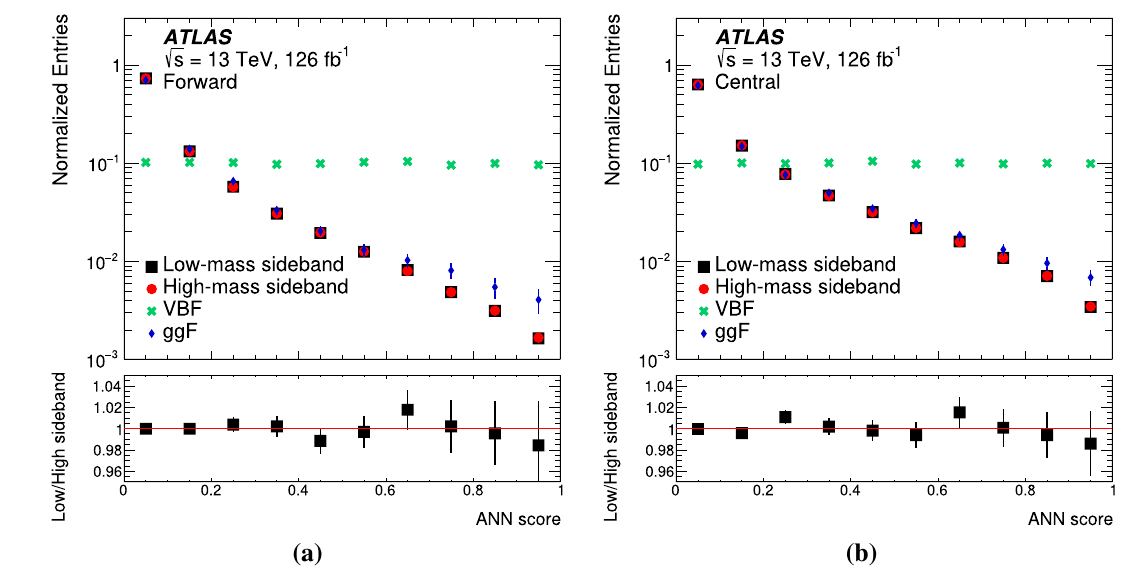
a Forward channel and b Central channel. The bottom panel shows the ratio of the low mass to high mass sidebands. The errors are statistical